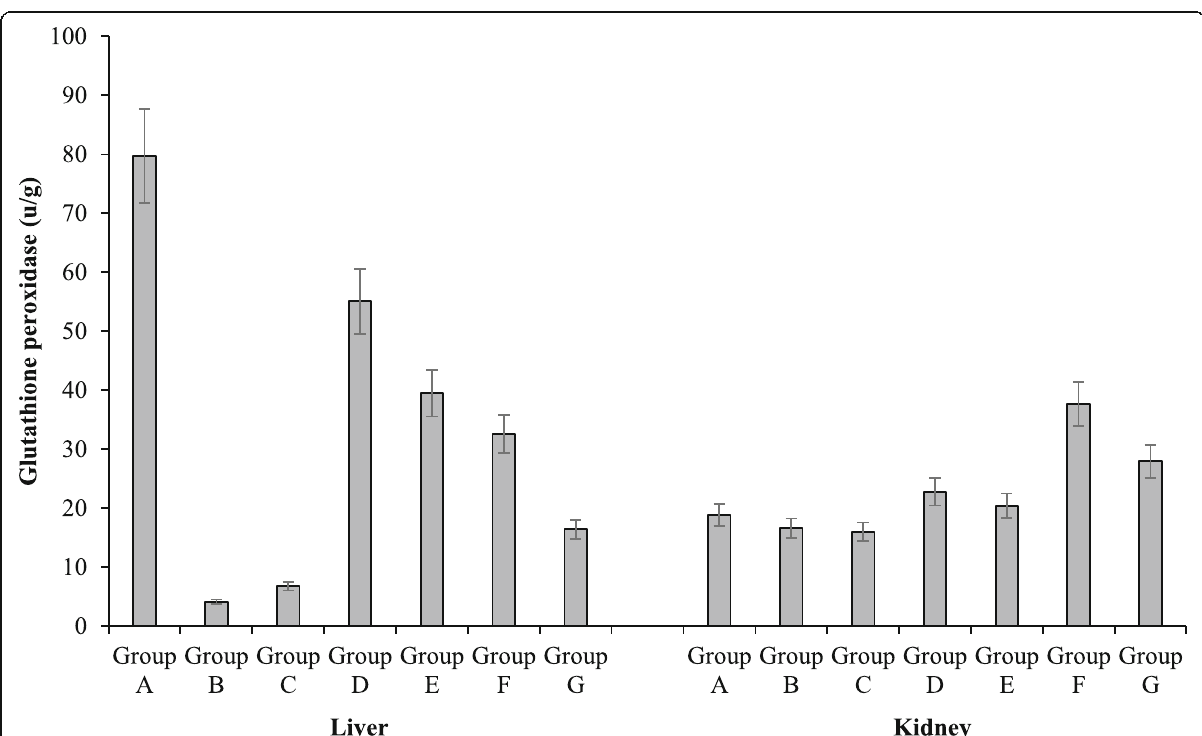
Fig. 4 Effects of aqueous extract of fruit pulp of A. digitata on the mean Glutathione peroxidase antioxidative activities and oxidative stress in the organs of albino rats in the different